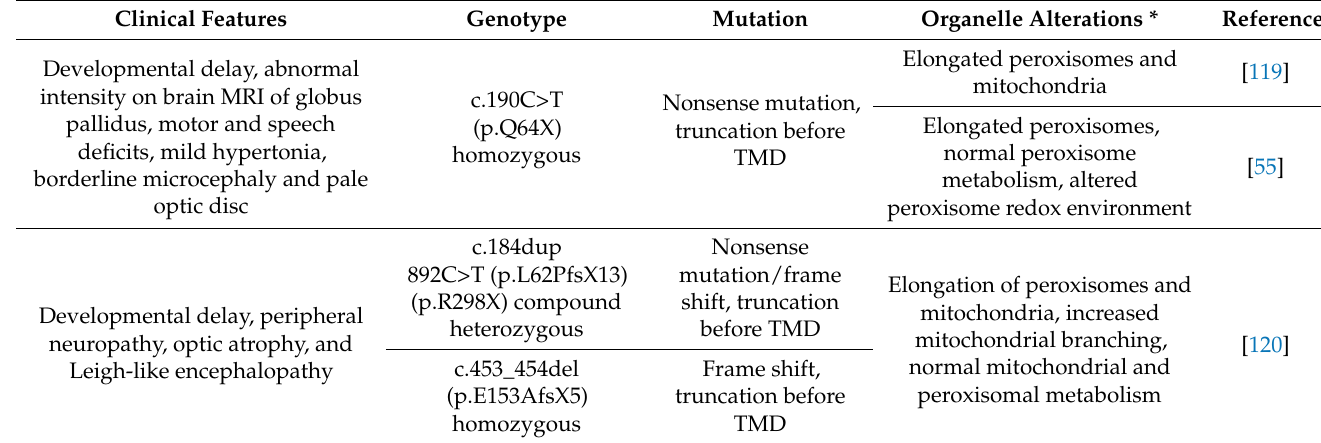
Table A2. Gene—MFF; Protein—mitochondrial fission factor; Function—recruitment of DRP1